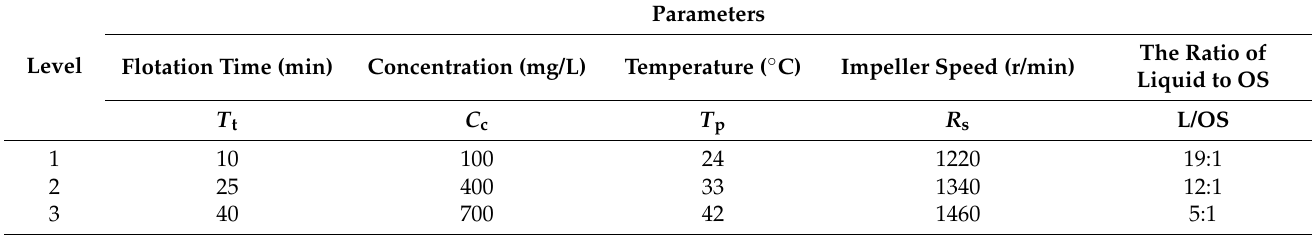
Table 3. Levels and parameters affecting the oil content of